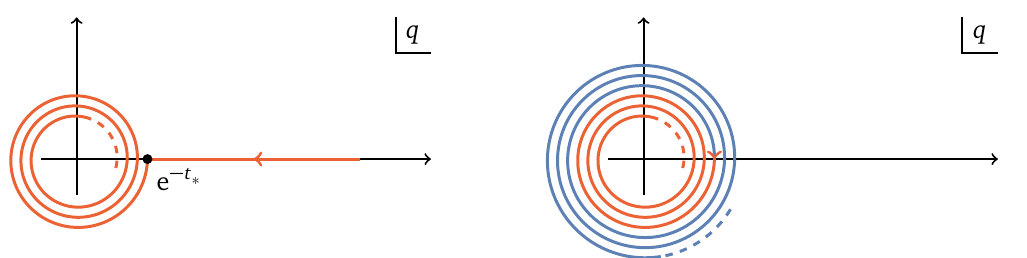
Figure 6: The integration contour in the neighborhood of the non-separating divisor. Only the spiralling part of the contour contributes to the imaginary part of the ampli- tude. The contour for the imaginary part of the amplitude is given by 1